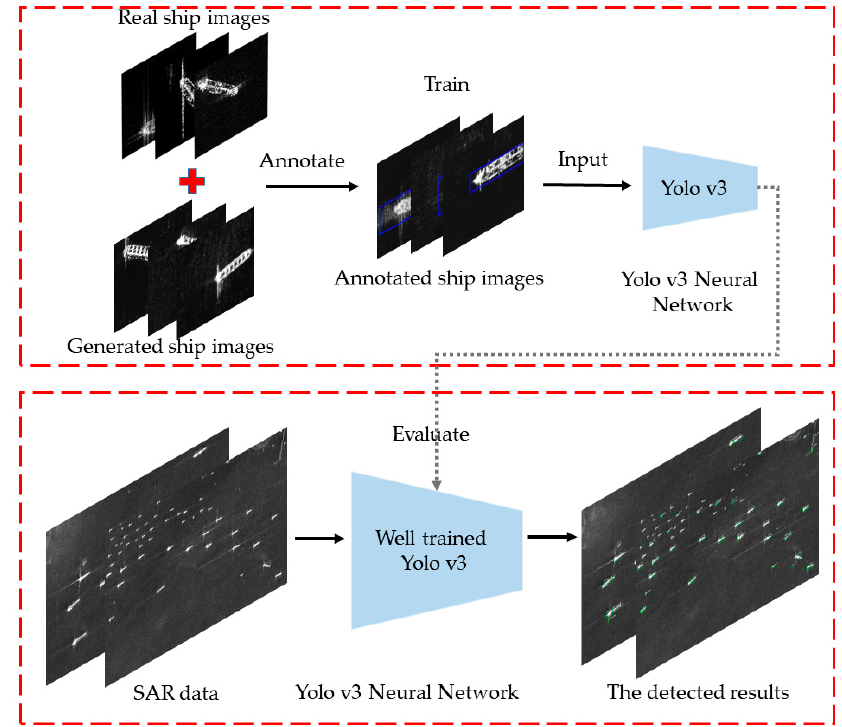
Figure 3. The flowchart of ship detection using Yolo v3 model and the composite dataset.